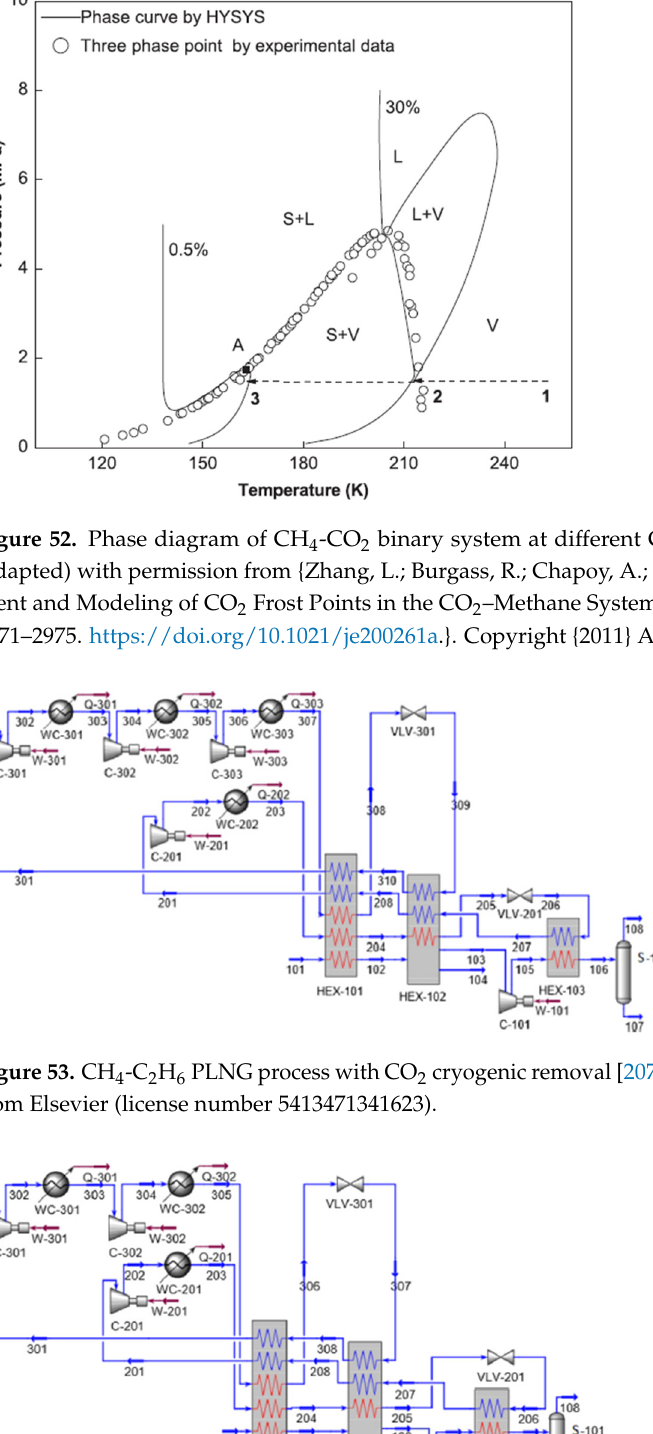
Reproduced with permission from Elsevier (license number 5413471341623). Figure 54. CH 4 -C 2 H 4 PLNG process with CO 2 cryogenic removal [207].